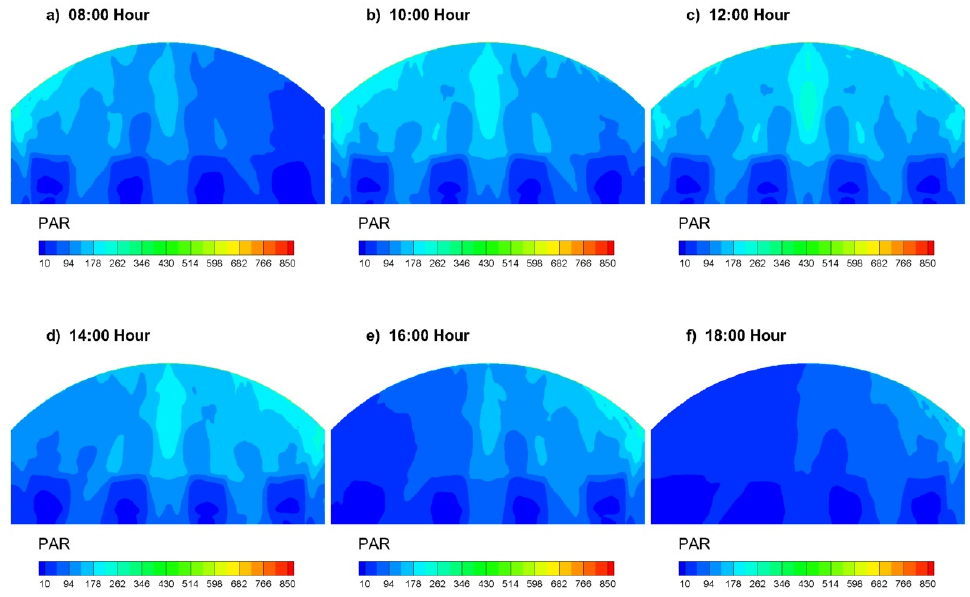
Figure 4. PAR isocontours for 21 June and τ n,PAR =45%.